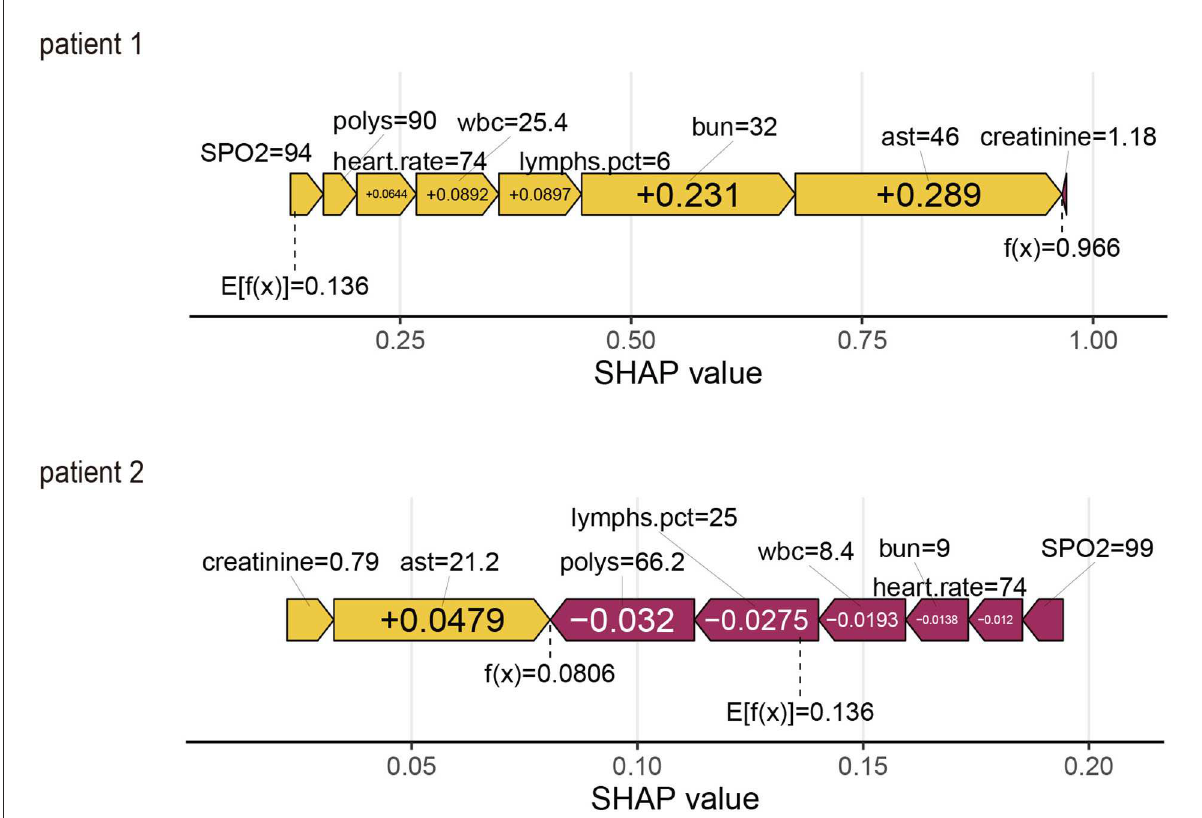
FIGURE5 SHapley Additive exPlanations (SHAP) force plot for two patients from the held-out validation set of the machine learning (ML)